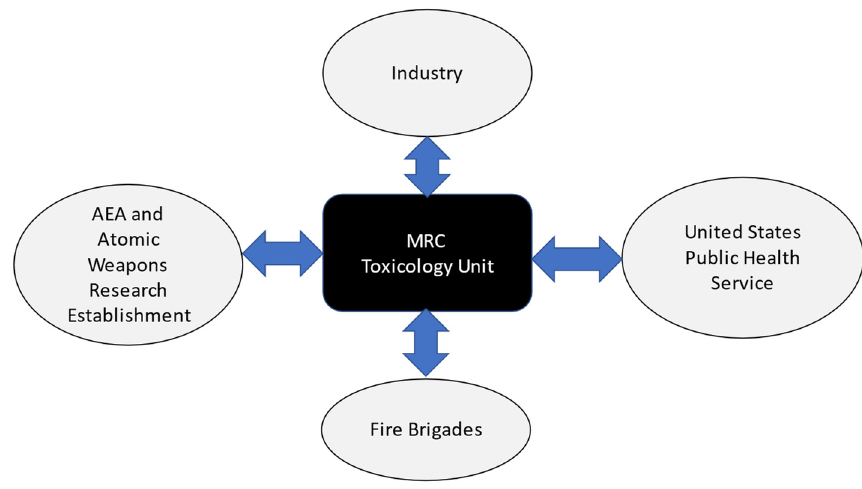
Figure 1. MRC toxicology unit links with UK and US agencies and industry. UK medical research council toxicology unit links with UK and US agencies.